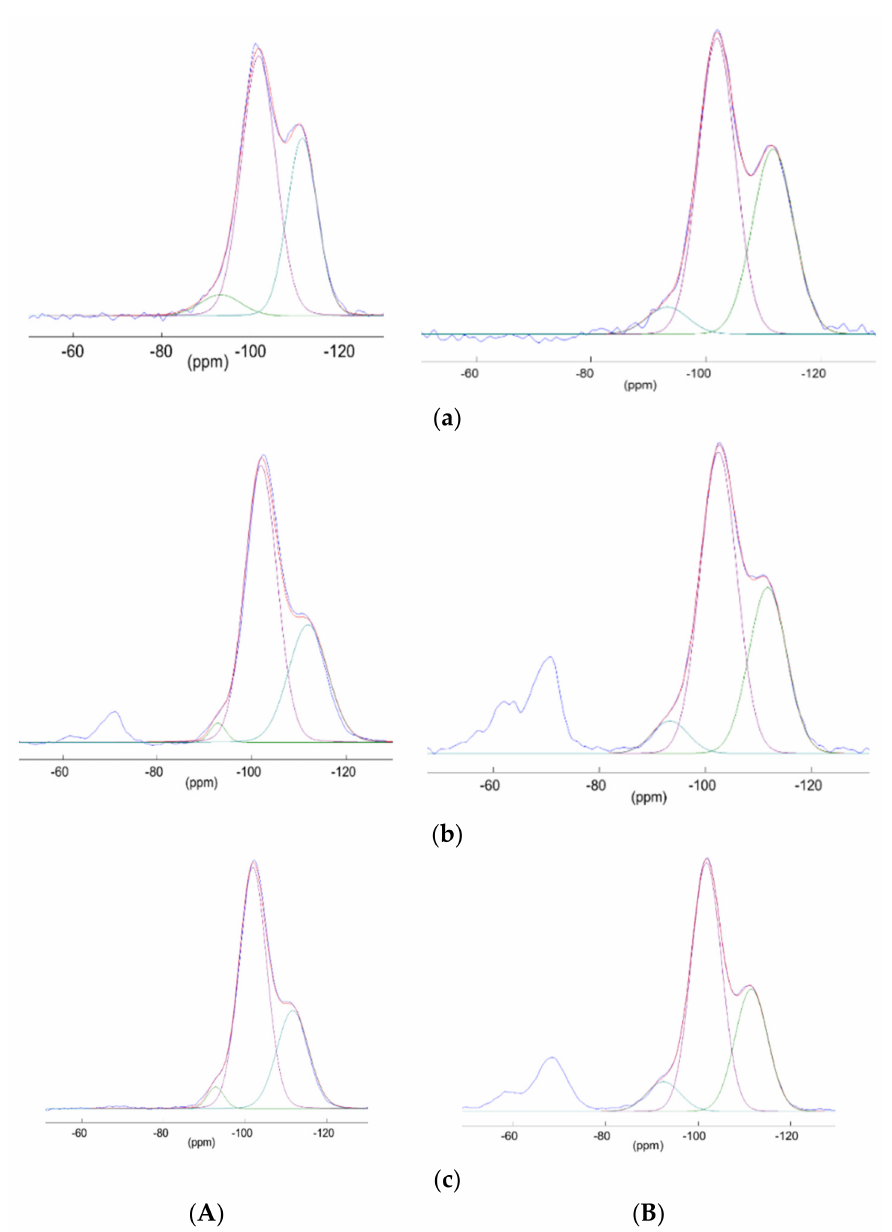
Figure 10. 29 Si CPMAS NMR spectra of SiO 2 ( a ) SiO 2 @CN ( b ), SiO 2 @COOH ( c ) from SiO 2 pro- duced in EtOH ( A ) and MeOH ( B ).